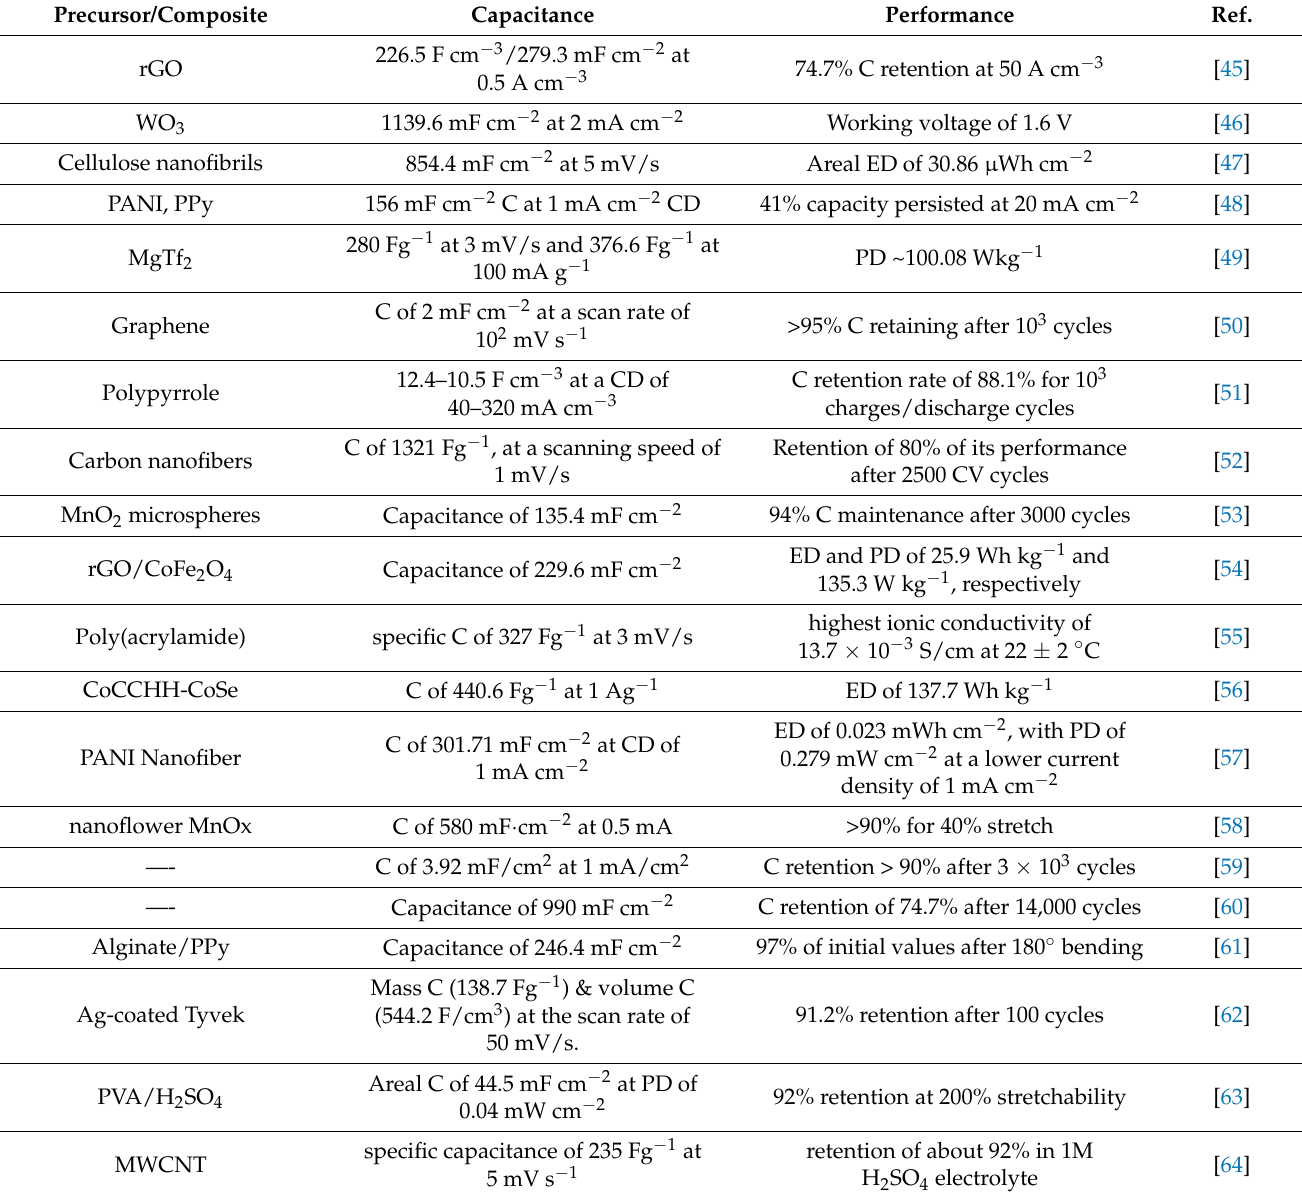
Table 2. Summary of supercapacitors based on PEDOT:PSS with capacitance (C) main